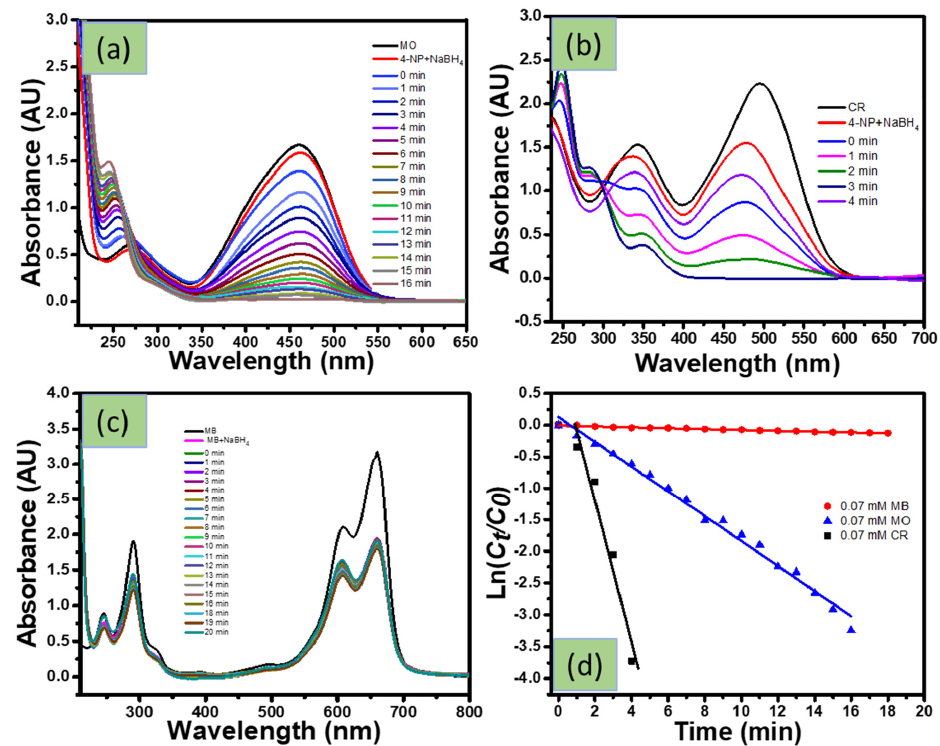
Figure 7. Typical UV–visible absorbance spectra of 4-MO ( a ), CR ( b ), and MB ( c ) and their and Ln(At/A0) vs. time plot ( d ) for the reduction reactions with NaBH 4 /Sn-Gd 2 O 3 @GH. The amount of the Sn-Gd 2 O 3 @GH catalyst was kept fixed (0.2